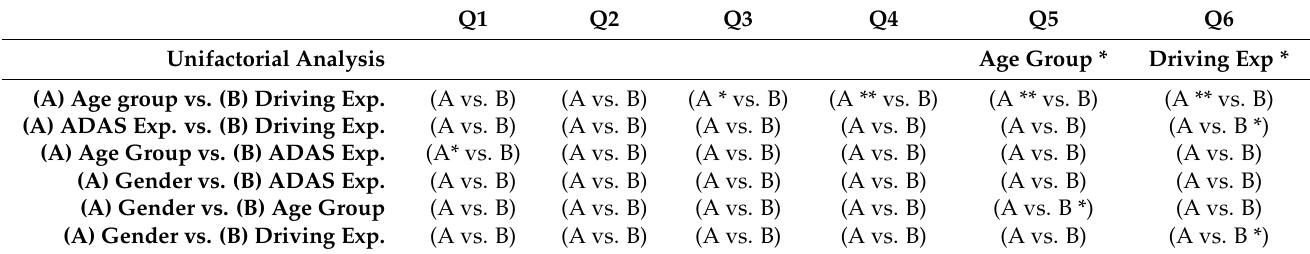
Table 3. Results of the two-way ANOVA analysis for the NASA TLX.